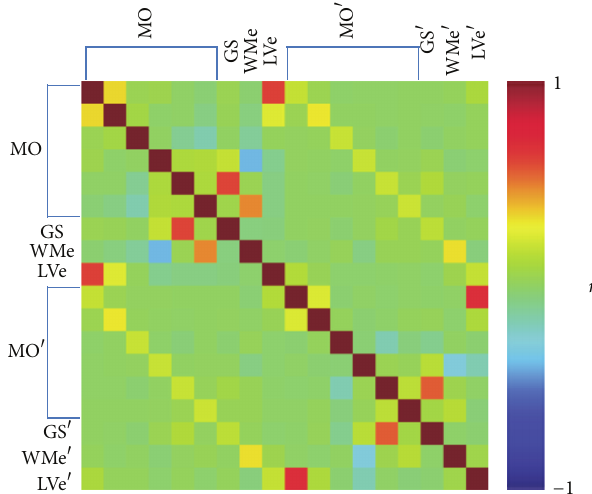
Figure 6: Cross-correlation matrix between the regressors. The correlation coefficients were averaged over all subjects ( 𝑁 = 22 ). MO represents the six regressors containing rigid-body motion parameter estimates (three translations and three rotations). GS is the average RS-FMRI time series over all voxels in the brain mask. WMe and LVe refer to the RS-FMRI time series averaged within eroded white matter and eroded lateral ventricles, respectively. Prime marks ( 󸀠 ) indicate the first differences of the regressors. The regressors were obtained from the time series that were despiked, slice-timing corrected, and then volume registered, and spatial smoothing was not applied to avoid mixing signal across different brain-tissue masks.